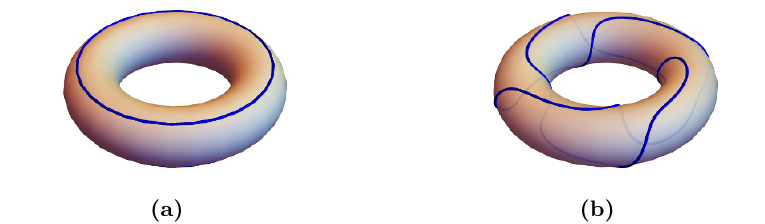
Figure 4. The action (2.13) of U n;m on the basis vectors corresponding to a given representation R j . It transforms the circular Wilson loop j j i depicted in (a) into the ( n; m ) torus knot j j n;m i illustrated in